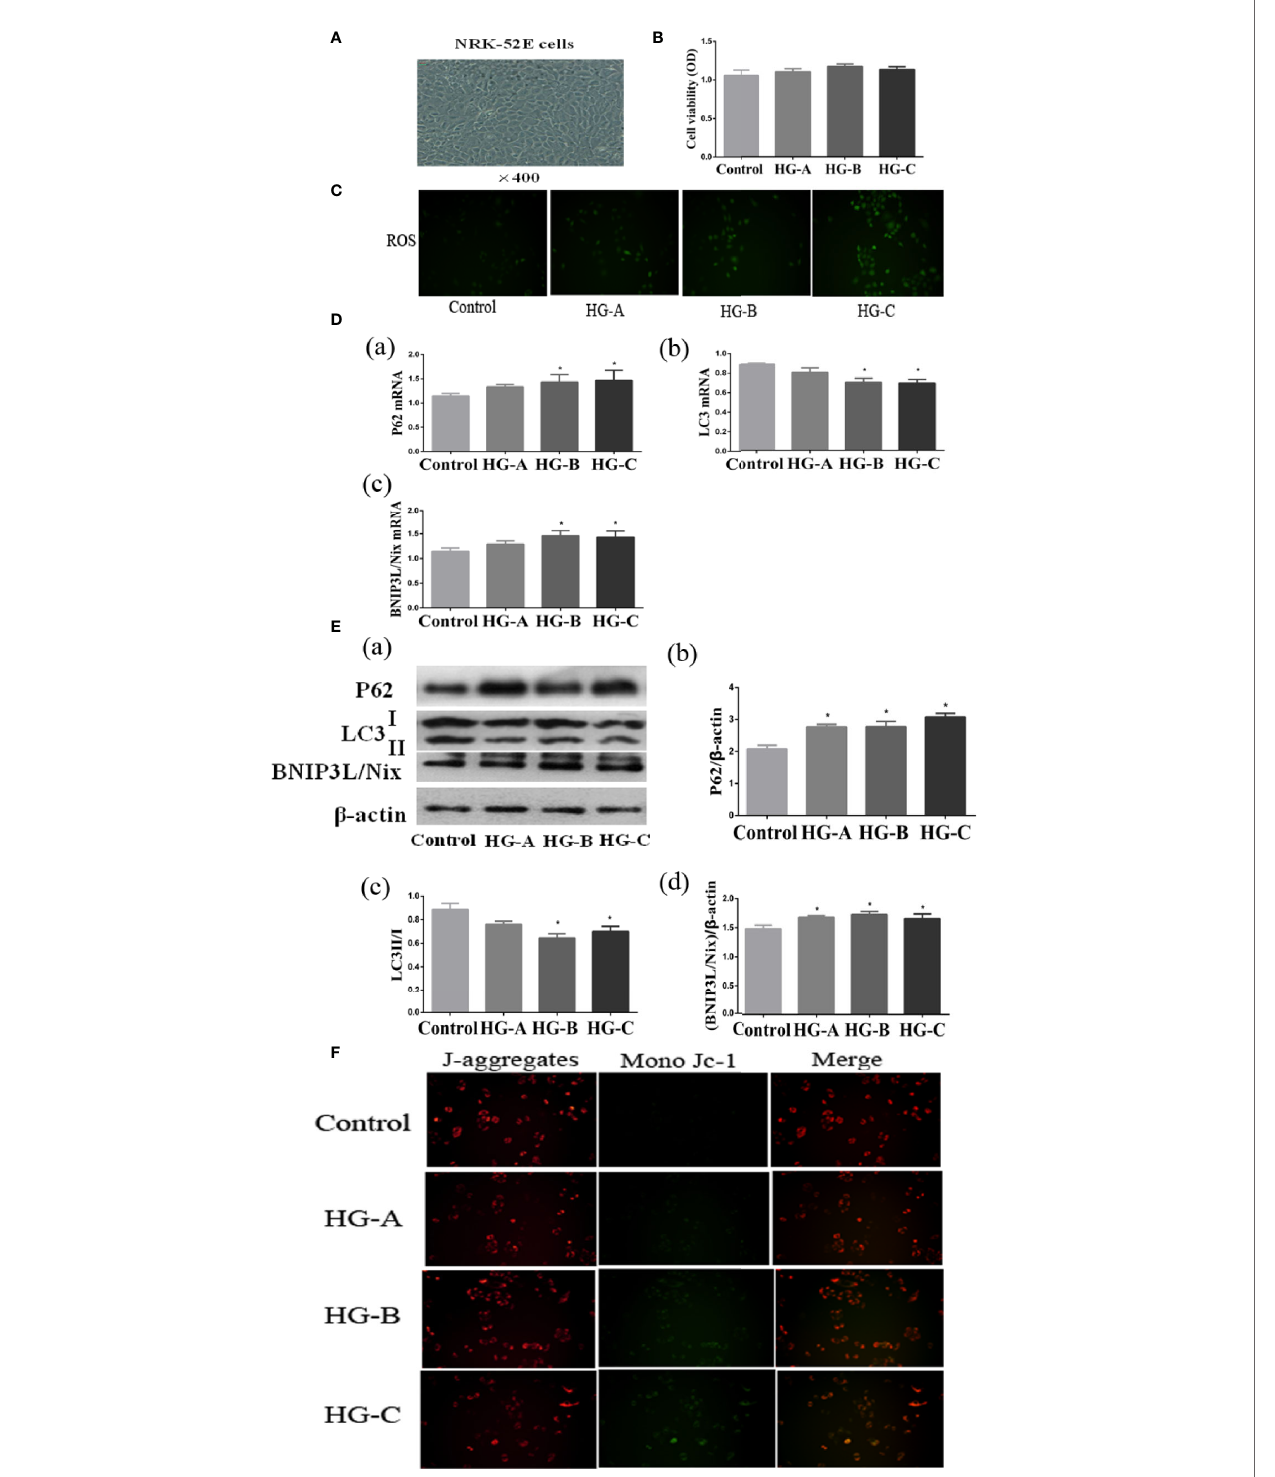
FIGURE 5 | Mitophagy was inhibited in NRK-52E cells under acute hyperglycemic state. (A, B) Morphology and viability of NRK-52E cells. (C) ROS detection in NRK-52E cells (200*). (D, E) Alterations of mitophagy related markers in NRK-52E cells in different groups. (F) Mitochondrial membrane potential changes in NRK- 52E cells (200*). Values are presented as means ± SD in each group. * P < 0.05 vs. Control. Control, control group; HG-A, hyperglycemia group A; HG-B, hyperglycemia group B; HG-C, hyperglycemia group